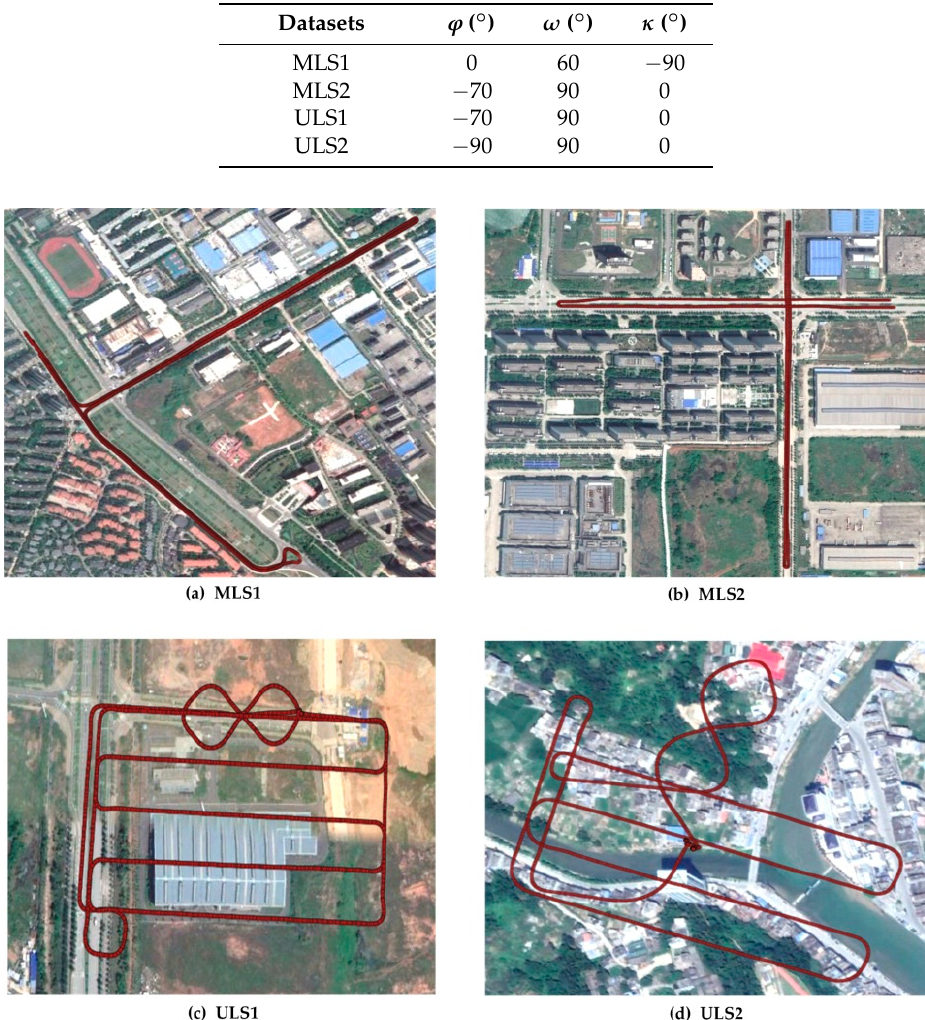
Figure 1. The scenes for acquiring the experimental data where the highlighted red polylines are the trajectories of the MLS and ULS systems.